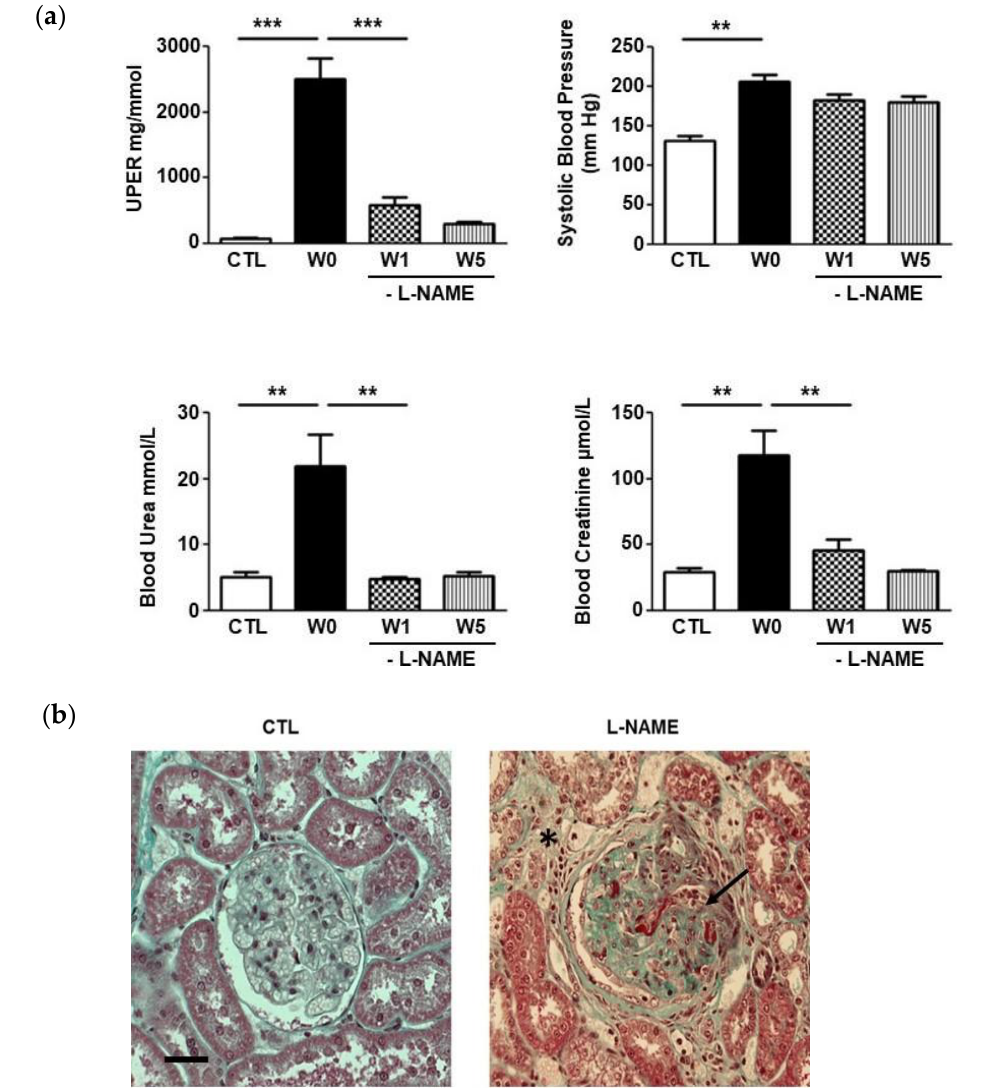
Figure 1. L-NAME impaired the renal function in rats and induced renal injuries . ( a ) Blood pressure and renal function in L-NAME rat model . Parameters studied included UPER, uremia and creatinemia in CTL, W0, W1, and W5 groups. At the peak of the disease (W0), the rats developed an elevated UPER accompanied by high systolic blood pressure and high levels of urea and serum creatinine. After stopping L-NAME treatment (W1 and W5), renal function recovered to normal (*** p < 0.001 and ** p < 0.01). ( b ) Histological evaluation of renal tissues. Representative examples of renal samples stained with Masson’s trichrome stain in Control (CTL) and L-NAME-treated rats. Glomerulosclerosis (black arrow) and intertial fibrosis (asterix) on the right photo. Bar = 10 μm. 2.2. ISM1 Gene Expression Is Associated to the Intensity of Renal Injury in L-NAME-Induced